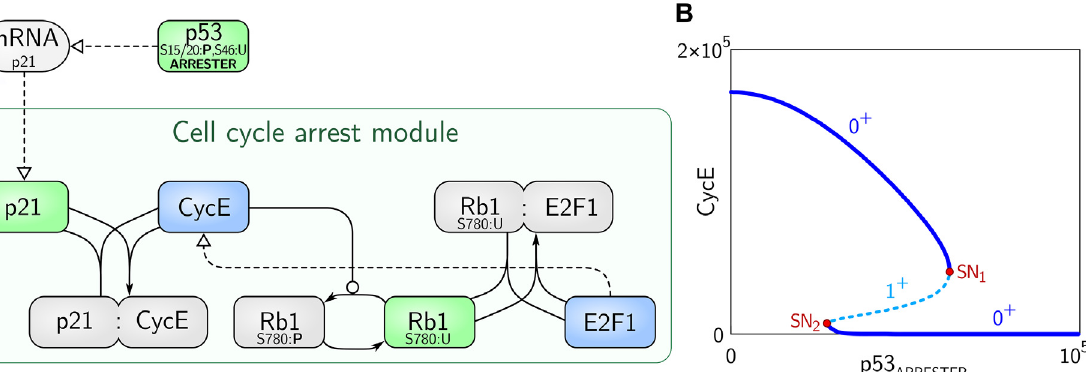
Fig 2. Scheme and the bifurcation diagram for the cell cycle arrest module. (A) Scheme: cell cycle-arresting proteins are represented with green boxes, proteins promoting cell cycle with blue boxes, other proteins or complexes with gray boxes. Bold ‘ P ’ denotes a phosphorylated protein residue. The arrow notation is same as in Fig 1. (B) Bifurcation diagram of CycE vs. p53 ARRESTER (bifurcation parameter). The stable and unstable steady states are indicated by solid and dashed lines, respectively. SN 1 and SN 2 denote saddle-node bifurcations. The number of eigenvalues with positive real parts is either one (1 + ) for the unstable steady state or zero (0 + ) for stable steady